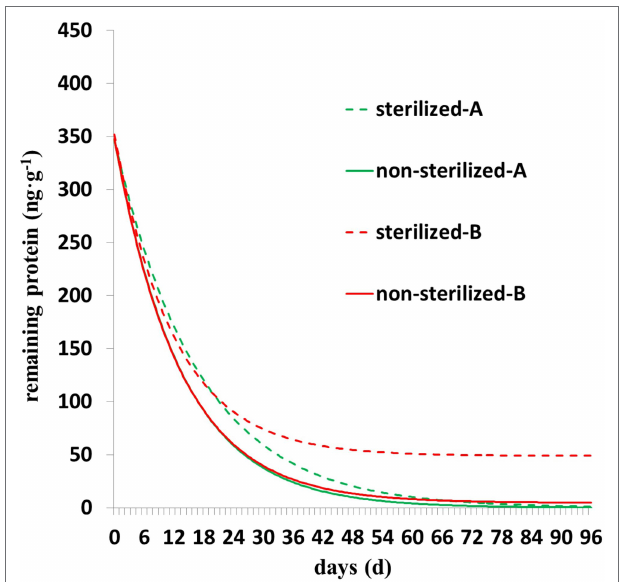
FIGURE 3 | The degradation dynamics of Cry1Ah protein in nonsterilized and sterilized soils. A (degradation model Y = ae − b * X ), B (degradation model Y = Y 0 + ae − b * X